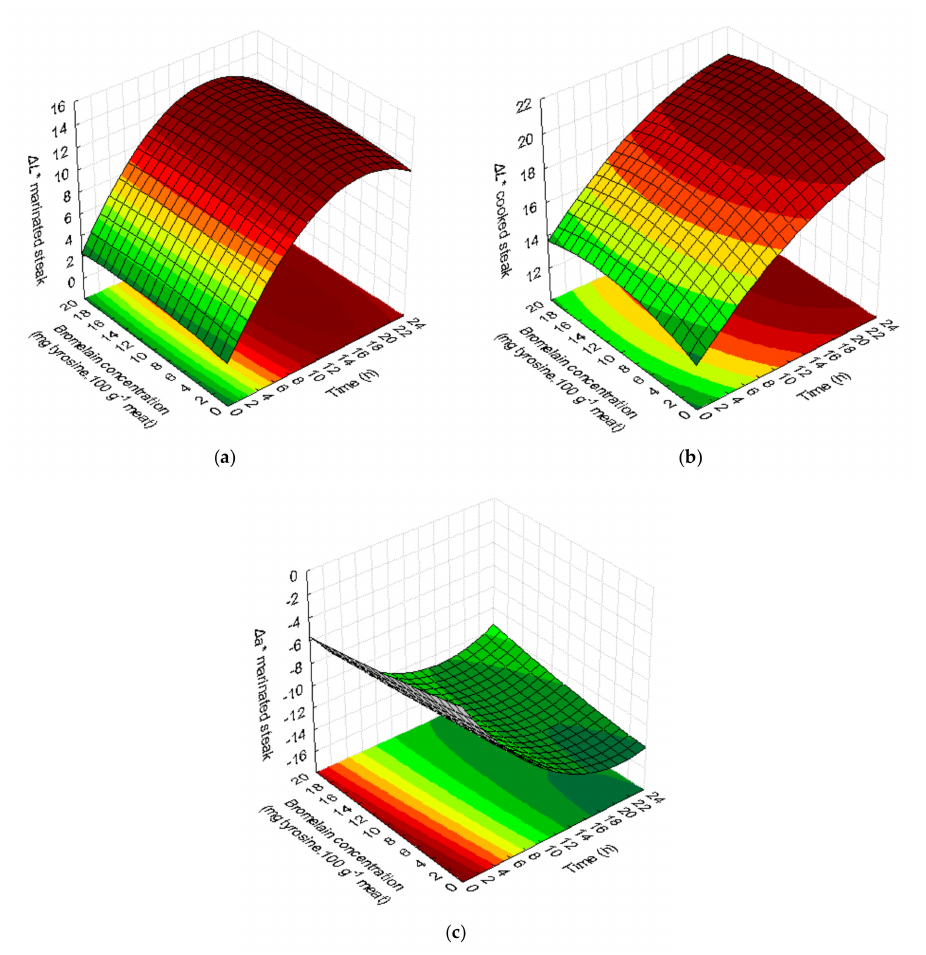
Figure 3. Response surfaces fitted for color parameters in marinated steaks: parameter ∆ L* ( a ), parameter ∆ a* ( c ), and parameter ∆ L*in cooked steaks ( b